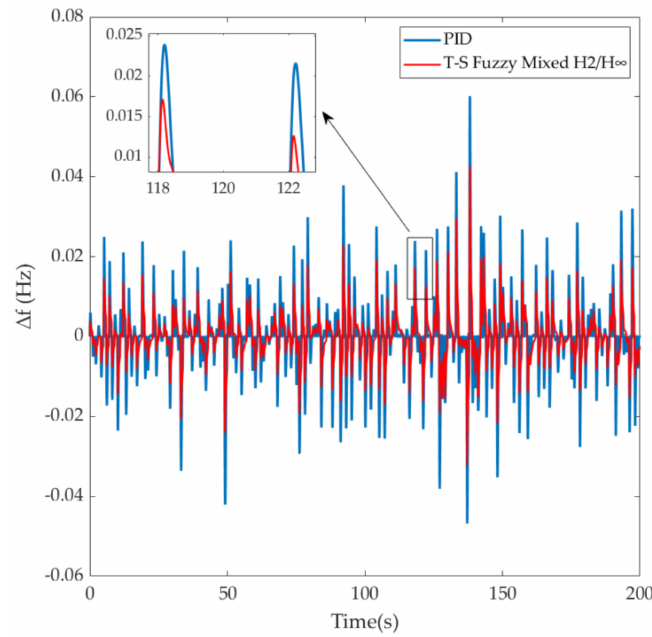
Figure 19. Frequency response of the